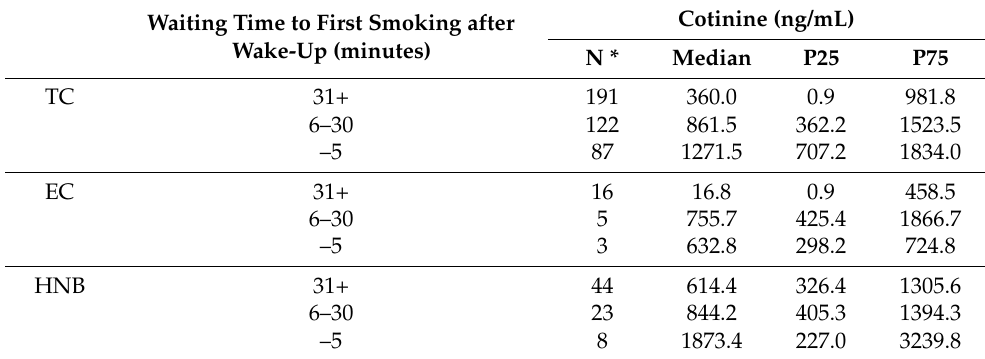
Table 3. Median and interquartile ranges of urinary cotinine level by waiting time to the first smoking after